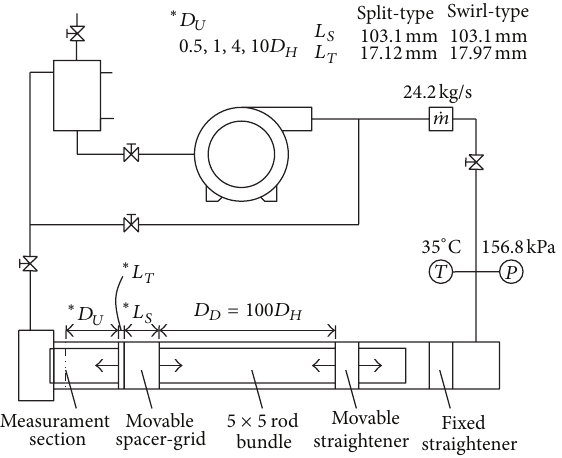
Figure 1: Schematic diagram of the MATiS-H test facility and location of